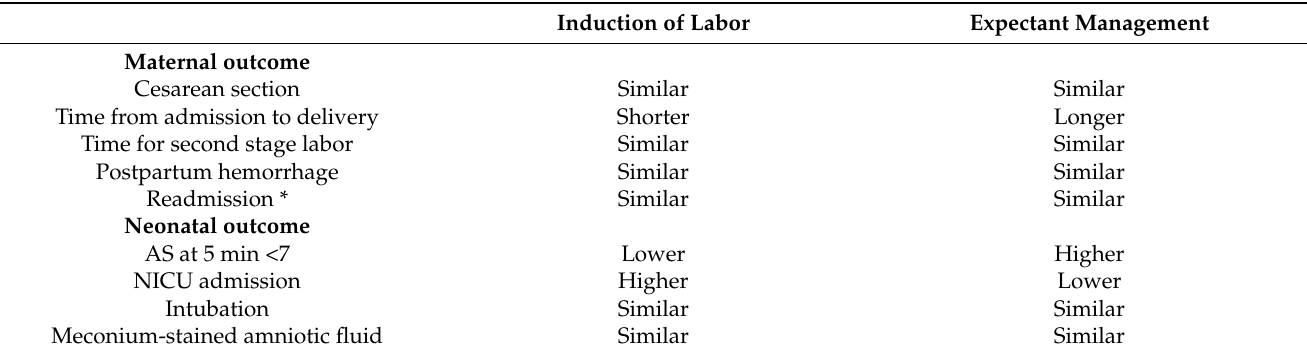
Table 5. Summary of obstetrics and maternal-fetal outcomes of induced labor and expectant manage-